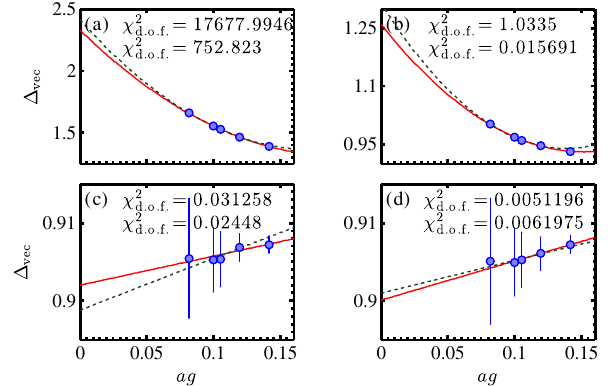
FIG. 6. Continuum extrapolation for the vector mass gap for 1 = 2 (a), j 1 (b), j 3 = 2 (c), and m=g ¼ 0 . 3 and j max ¼ max ¼ max ¼ 2 (d). The red line shows the fit used to extract the central j max ¼ value. The dashed green line shows the same fit omitting the largest lattice spacing to estimate the systematic error. The values indicate the χ 2 of the two fits, where the upper one corresponds d : o : f : to the red solid line and the lower one to the green dashed line. Notice the different scales of the y axis between panels (a),(b) and (c),(d), showing that systematic errors are much larger for j max ¼ 1 = 2 and 1. j ¼ 3 = 2 and 2, quadratic corrections in ag are irrelevant max and our data are well described by a linear fit in the range of lattice spacings we study (for details, see Appendix E). The final results obtained after the extrapolation for various masses and truncations are shown in Fig. 7. As the figure reveals, there is a considerable difference between the values obtained for j ¼ 1 = 2 , 1, 3 = 2 . Only for values of max